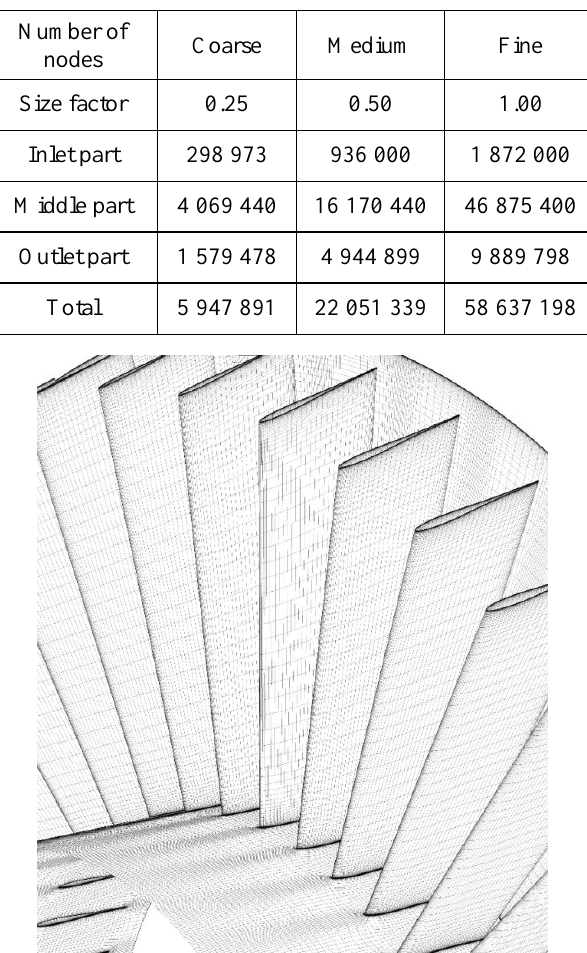
Table 1. Mesh sensitivity analysis: different mesh densities presented by mesh nodes (the outlet part is with all diffuser internal struts).